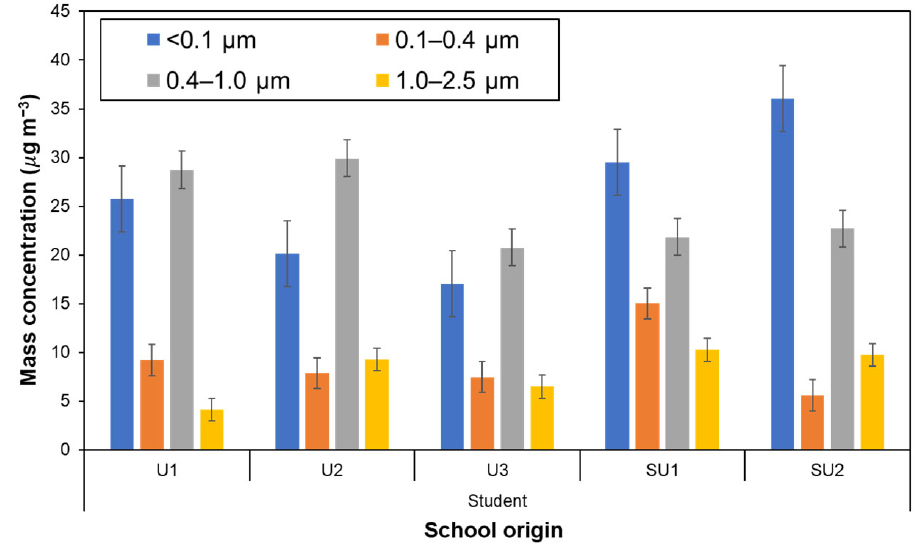
Figure 4. Average mass concentrations of size-segregated particles down to the PM 0.1 fraction to schoolchildren participants by personal exposure.